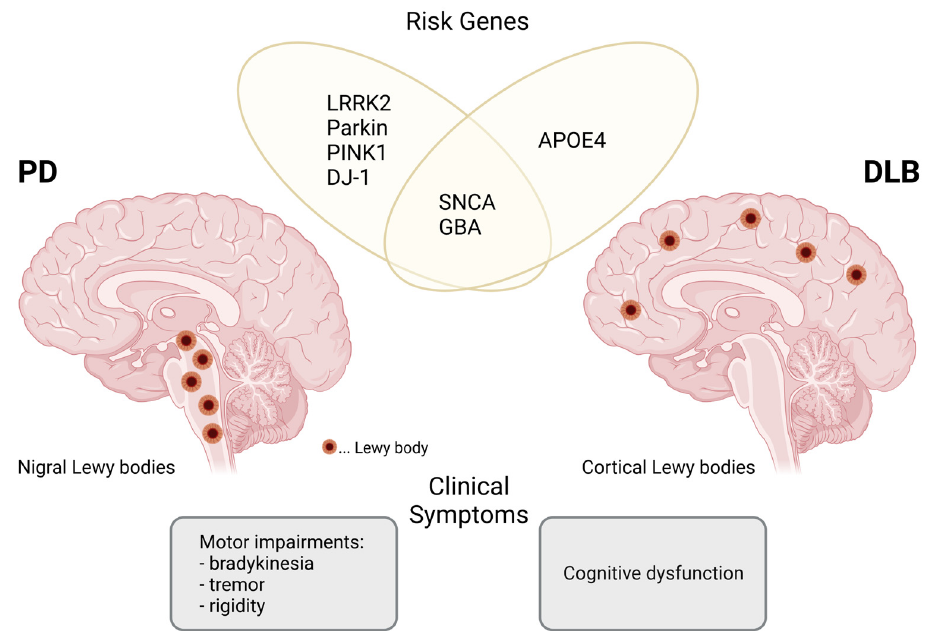
Figure 1. Clinical differentiation between Parkinson’s disease (PD) and dementia with Lewy bodies (DLB) and common genetic determinants. In the PD brain, aggregated α -synuclein and Lewy bodies (depicted as red circles) are mainly located in the substantia nigra and the brainstem, which is accompanied by dopaminergic neuronal death, causing typical parkinsonian motor symptoms. In DLB, α -synuclein accumulations and Lewy bodies are predominantly found in cortical brain areas involved in cognitive impairments. PD and DLB both feature individual predisposition genes (PD: LRRK2, Parkin, PINK1 and DJ-1; DLB: APOE4), but also share risk genes that influence the aggregation of α -synuclein (e.g., SNCA and GBA). Created with BioRender.com (last accessed on 1 January 2022).